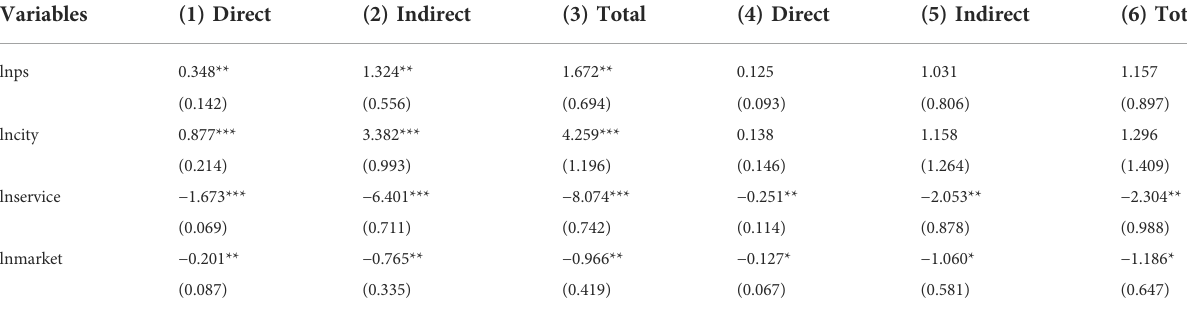
TABLE 5 Spatial econometric regression results of different weight